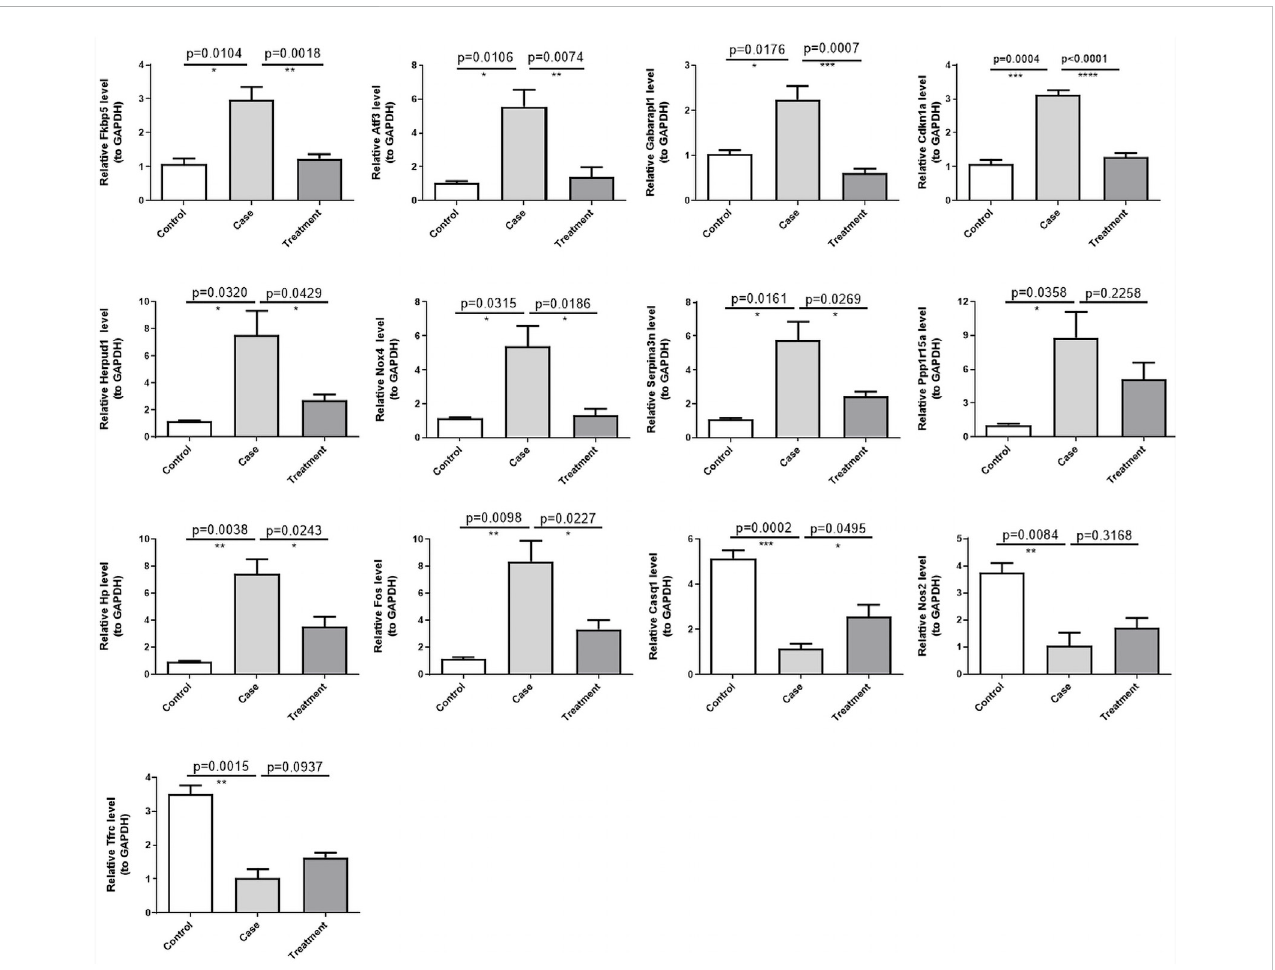
FIGURE 7 Validation of the expression of 13 DE-ERSRGs by RT-qPCR. Validation of the expression levels of 13 DE-ERSRGs in mice tissue samples by quantitative RT-PCR. Error bars show mean ± SD. Data are representative of three independent experiments. * p < .05, ** p < .01, *** p < .001.